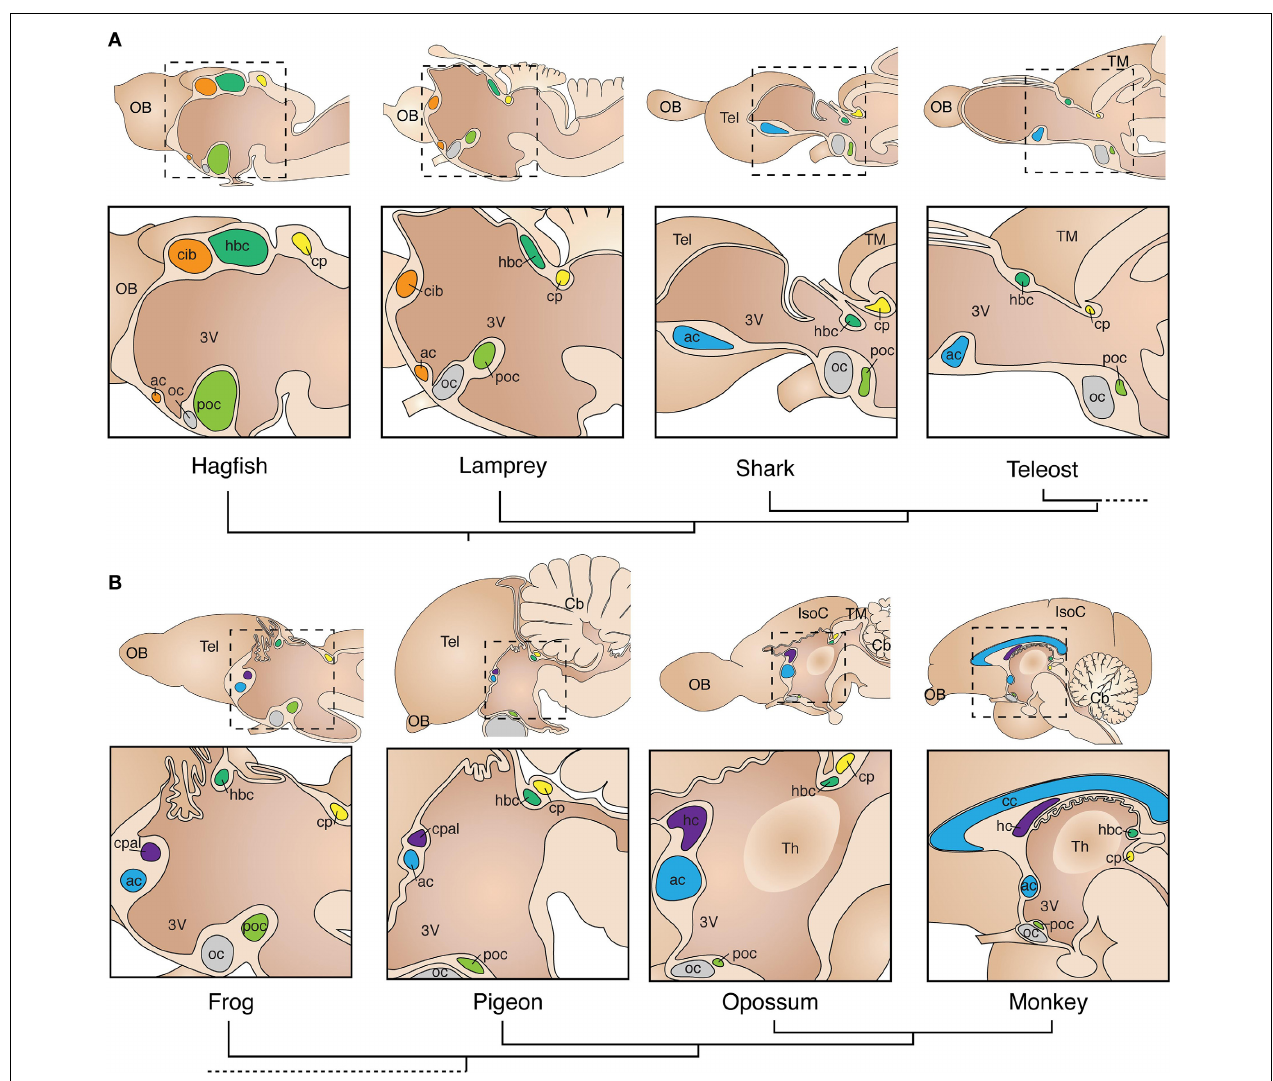
FIGURE 2 | Conservation of commissural systems across adult vertebrate species. (A) Commissures in non-tetrapod species. Note the conserved position of commissures relative to each other within and between species, commissures are color-coded according to homology hypotheses. The commissura interbulbaris (cib) and anterior commissure (ac) of lampreys and hagfish are depicted here with a unique color (orange) to indicate the uncertainty of definitive homology with other vertebrates. (B) Tetrapods are characterized by the evolution of a distinct pallial commissure (cpal) in close